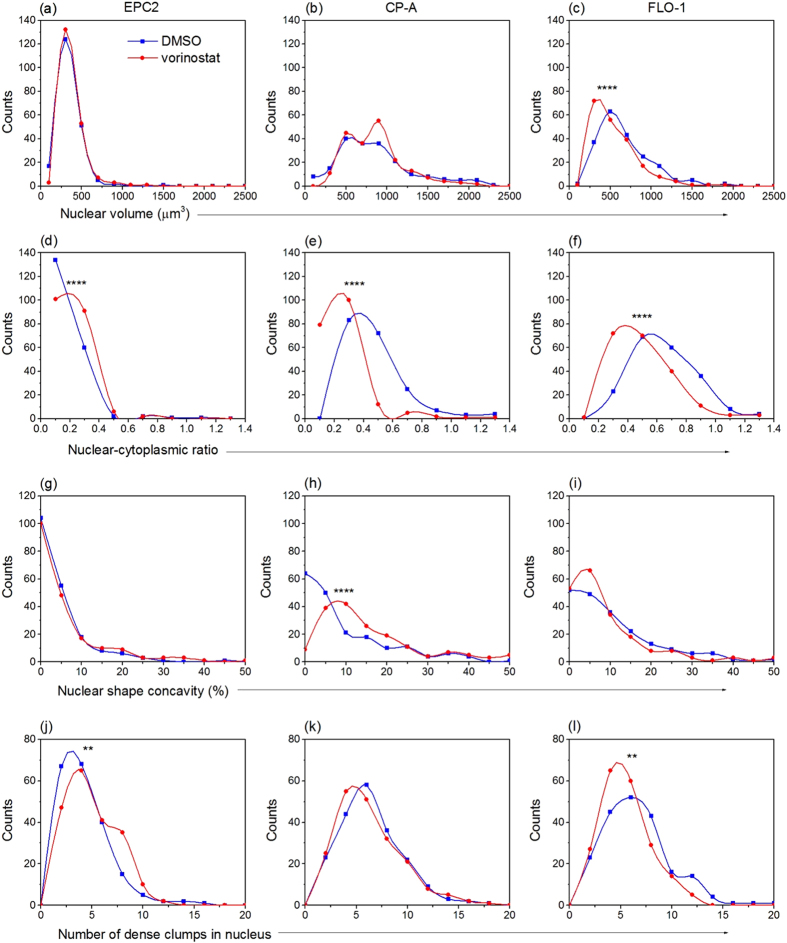
Vorinostat treatment differentially alters 3D nuclear structure and heterogeneity in normal squamous (EPC2), metaplastic Barrett’s (CP-A), and adenocarcinoma (FLO-1) esophageal epithelial cells.Histograms illustrate the impact of 0.94 μM vorinostat (red curves) on: (a–c) nuclear volume; (d–f) nuclear cytoplasmic (NC) ratio; (g–i) nuclear shape concavity; (j-l) the number of intra-nuclear clumps and morphological heterogeneity relative to DMSO treated cells (blue curves). P-value indicators: **p < 0.01, ****p < 0.0001. All three cell types exhibited statistically significant changes in NC ratio upon treatment; NC ratio increased in EPC2 cells and decreased in CP-A and FLO-1 cells. Treated FLO-1 cells additionally presented reductions in nuclear volume and intra-nuclear clumpiness. Drug exposure also caused CP-A nuclei to become significantly more concave-shaped and caused an increase in intra-nuclear clumpiness in EPC2 cell nuclei. Histograms were generated from 200 cells per condition. Data were analyzed in Prism6 using the Mann-Whitney test.